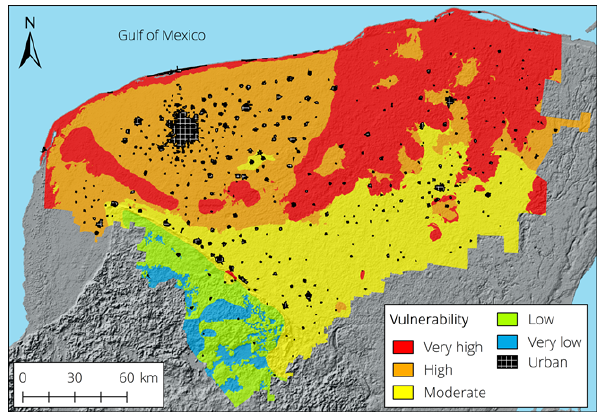
Figure 9. The IKAV-P